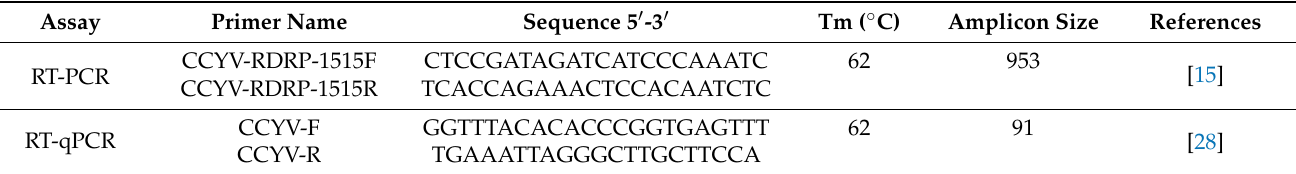
Table 1. Primers used to detect cucurbit chlorotic yellows virus (CCYV) in this